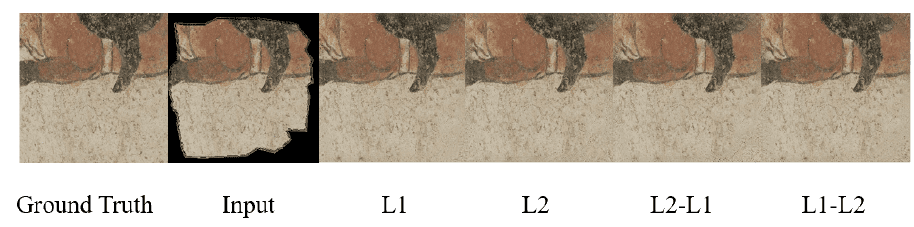
Figure 8. Subjective comparison of different training methods.